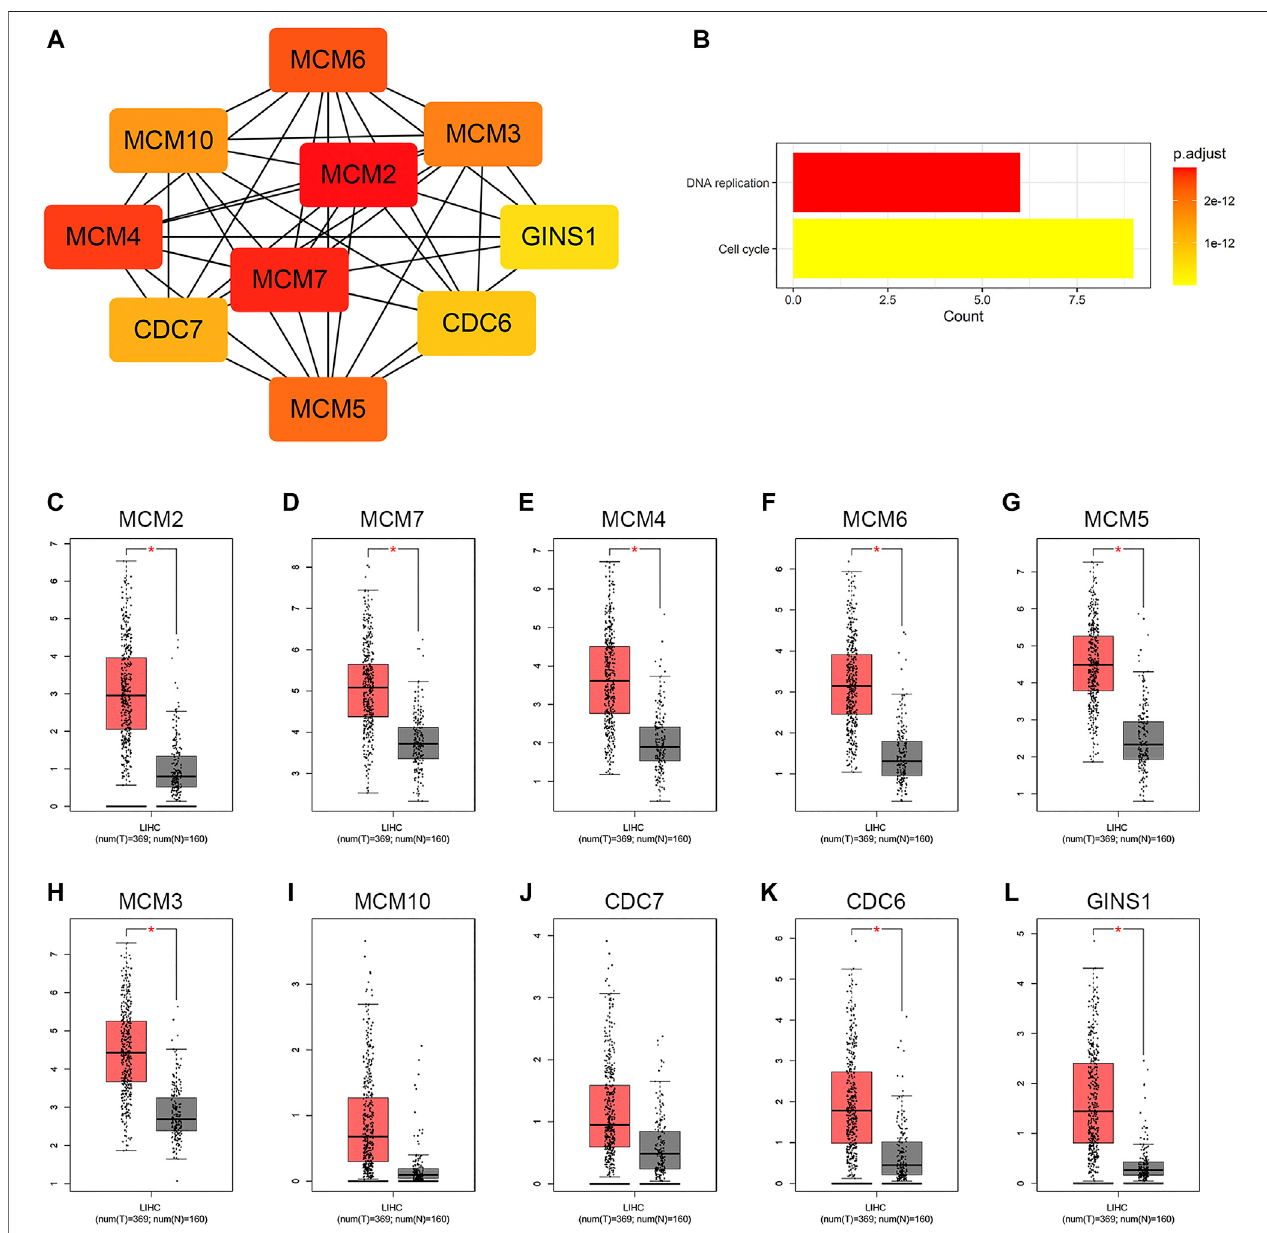
FIGURE 5 | Identi fi cation of hub genes in the PPI network. (A) Hub gene network. (B) KEGG pathway analysis of the hub genes. (C − L) Differential expression analysis of the hub genes in GEPIA. Tumor tissue is shown in red, and normal tissue is shown in gray. PPI, protein-protein interaction; KEGG, Kyoto Encyclopedia of Genes and Genomes; GEPIA, Gene Expression Pro fi ling Interactive Analysis; LIHC, liver hepatocellular carcinoma; T, tumor; N, normal.